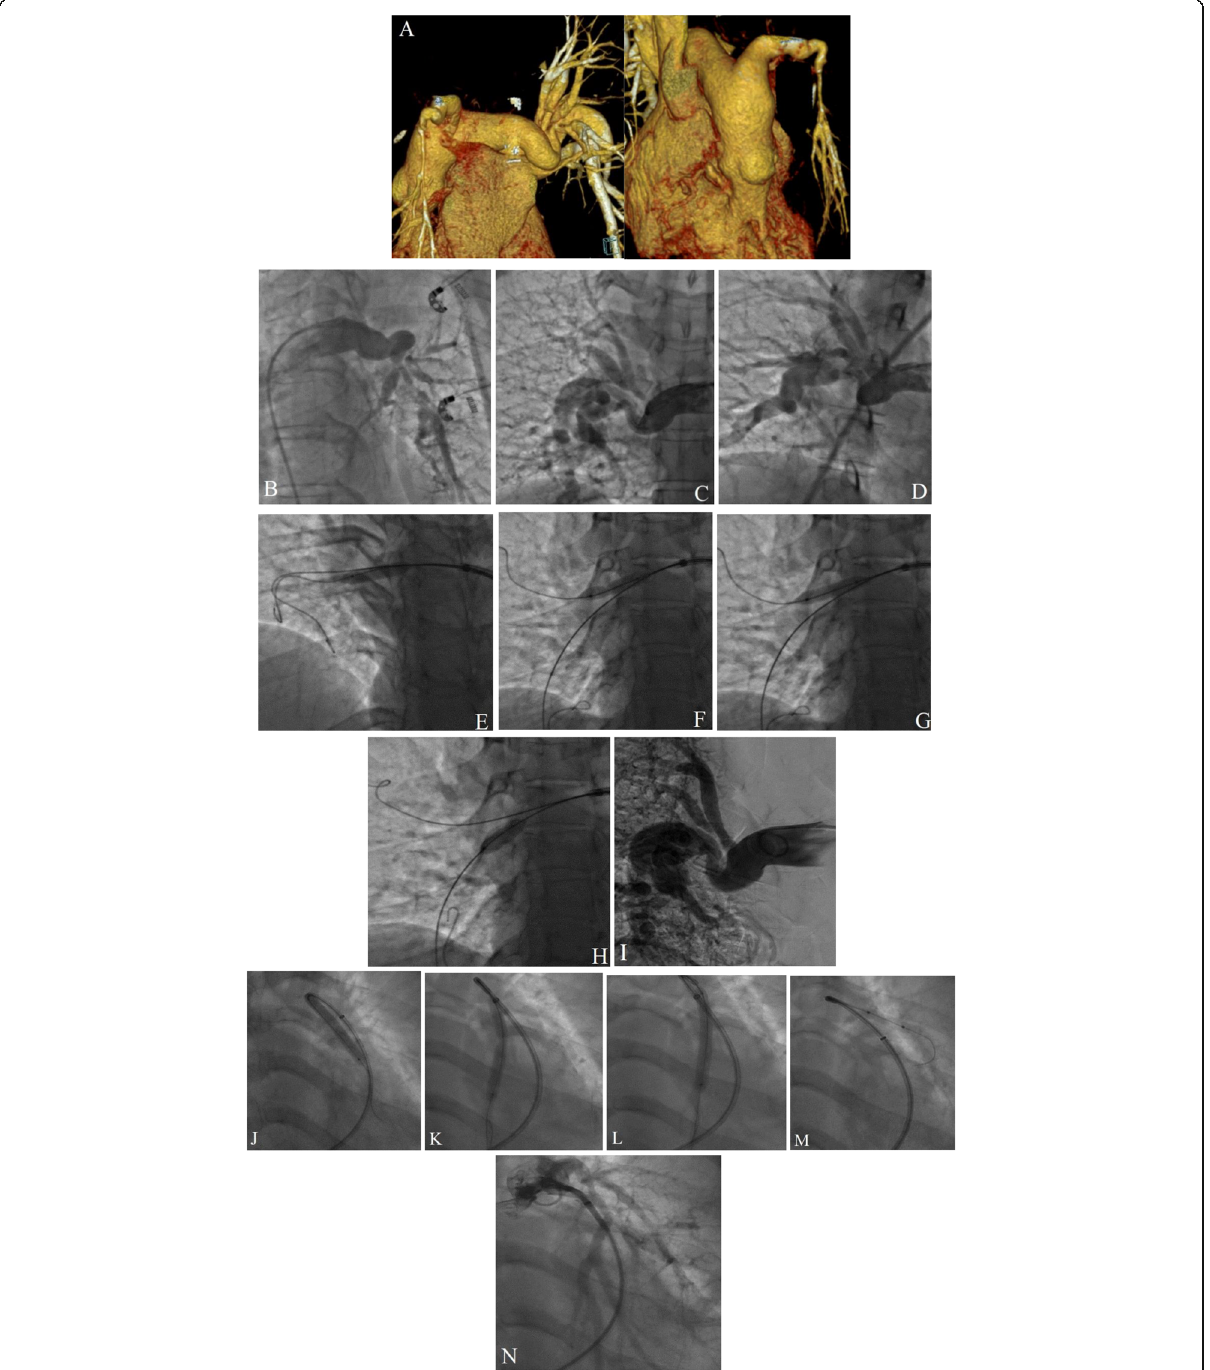
Fig. 1 (See legend on next